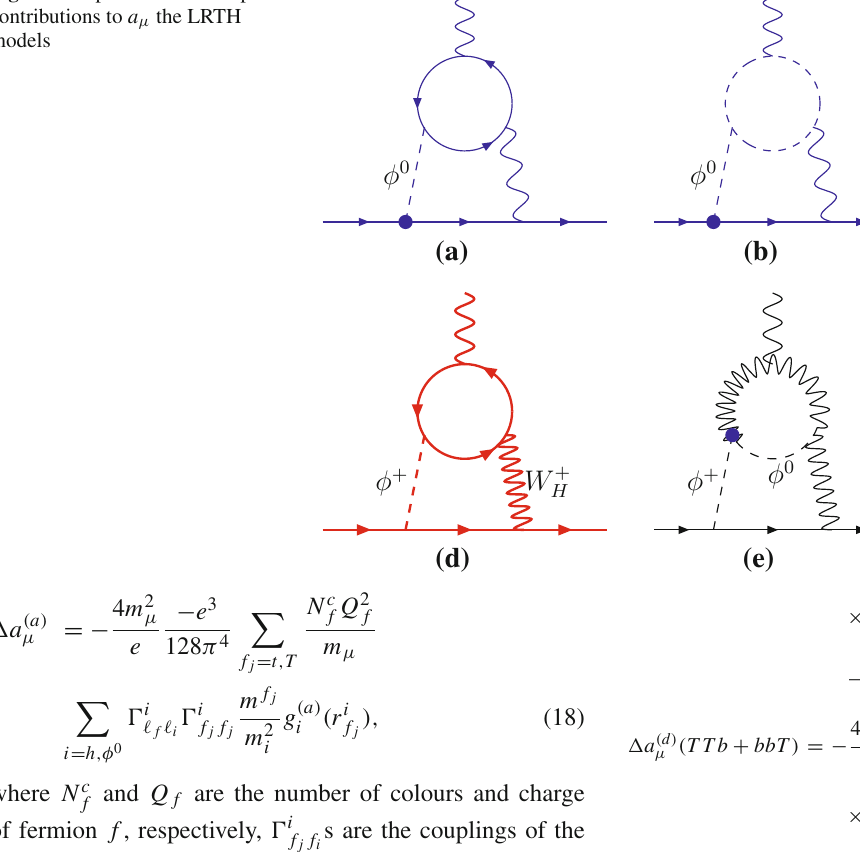
Fig. 2 The potential two-loop contributions to a μ the LRTH